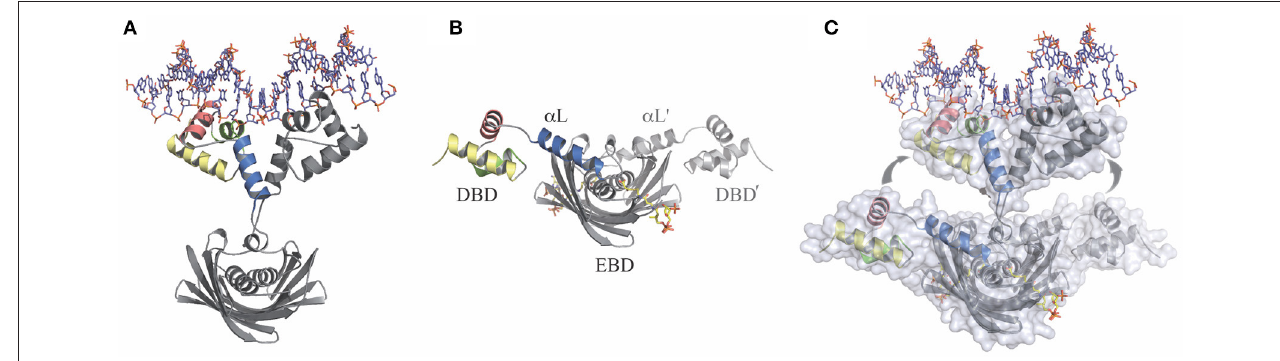
FIGURE 2 | The transitional switch between the relaxed and tense states of FapR involves a significant structural rearrangement of the DBDs. (A) Relaxed state: FapR in complex with DNA in which the amphipathic linker α -helix ( α L) from each protomer associates with each other. (B) Tense state: FapR in complex with malonyl-CoA (shown in stick representation). (C) Superposition of the two conformational states of the repressor illustrating the structural transition which involves substantial changes and large ( ∼ 30 Å) inter-domain movements. Solvent accessible surfaces are shown in transparent to highlight the DNA-induced dissociation of the invariant effector-binding domain (EBD) from the DNA-binding domains (DBDs). The molecules are shown in light (relaxed) and dark (tense) gray, except for the helices from one DBD (colored). Adapted from Albanesi et al.